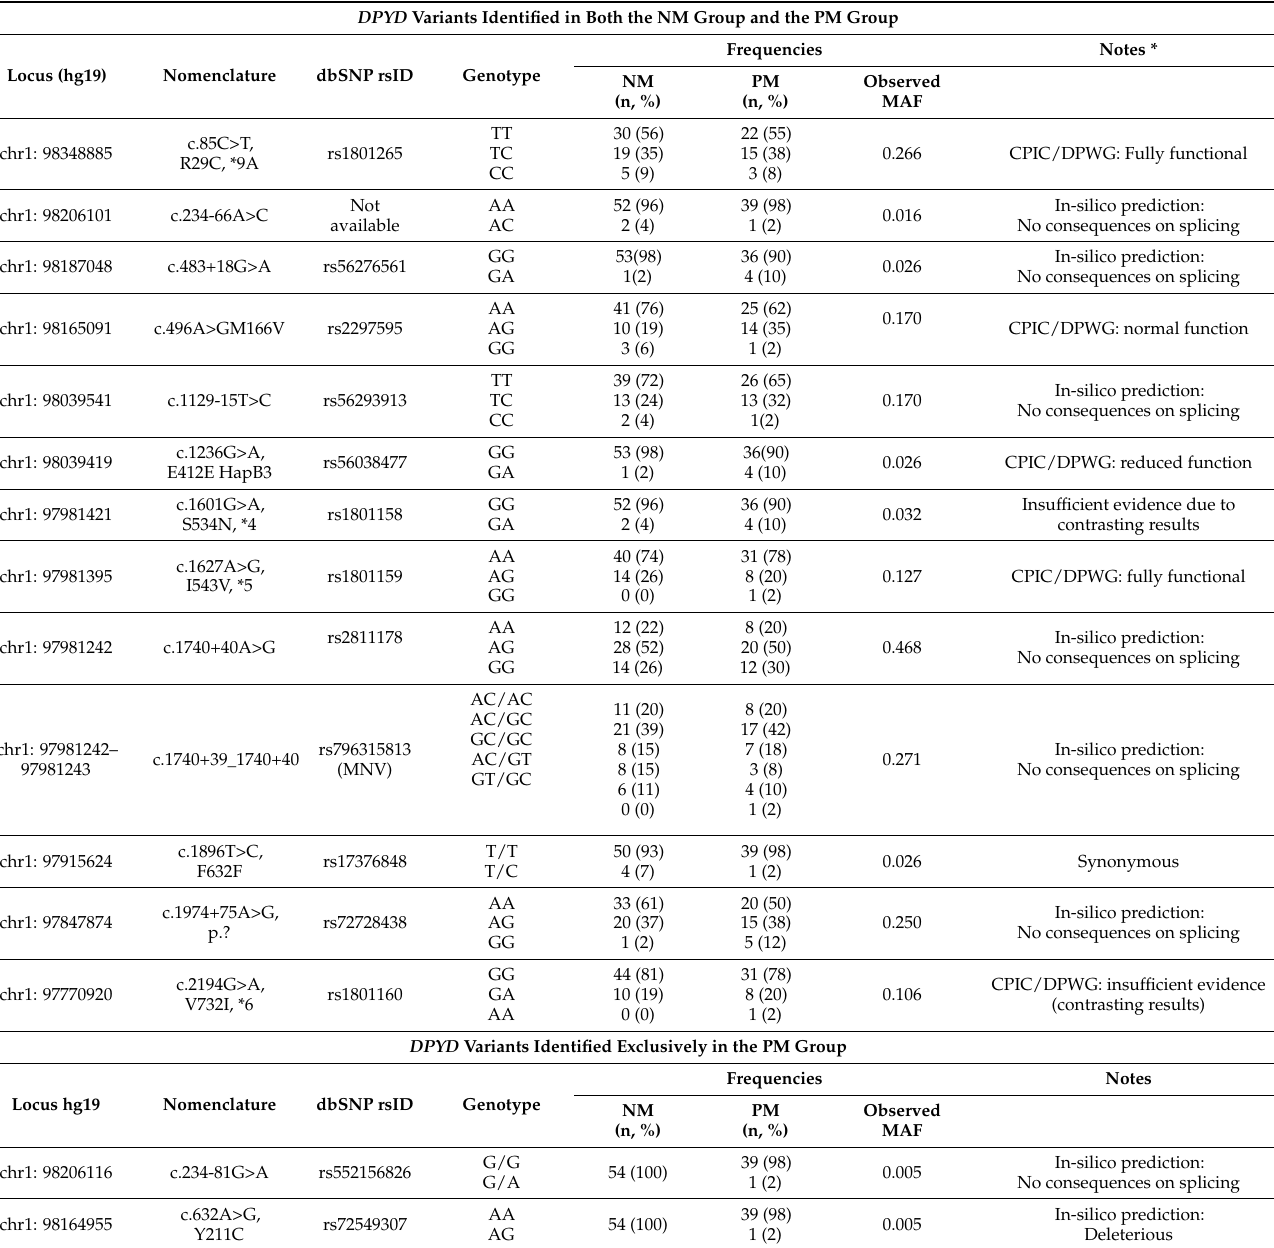
Table 1. List of identified DPYD